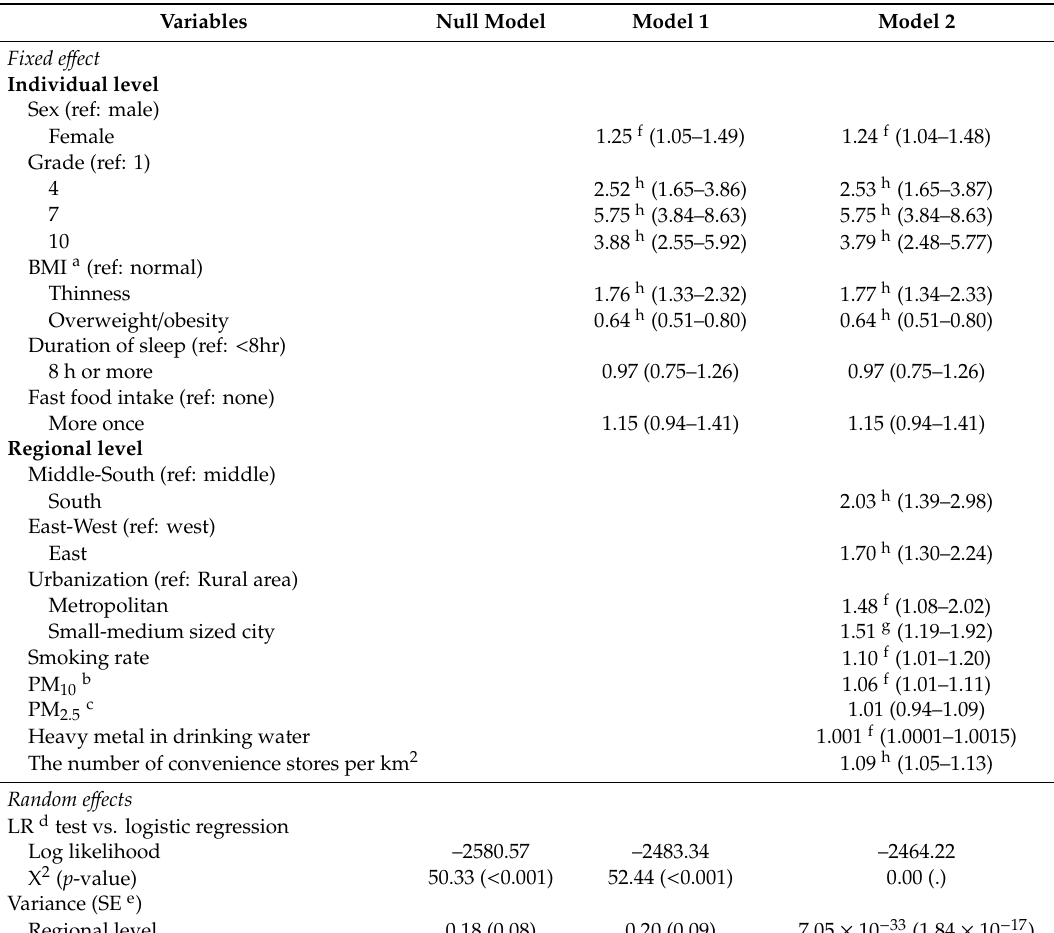
Table 4. Adjusted odd ratios (95% confidence interval) of the two-level logistic regression model for proteinuria among children and